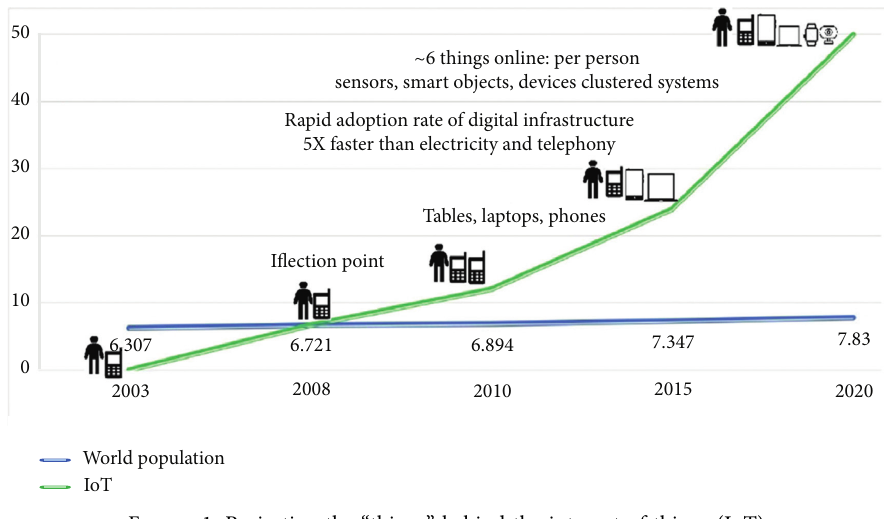
Figure 1: Projecting the “things” behind the internet of things